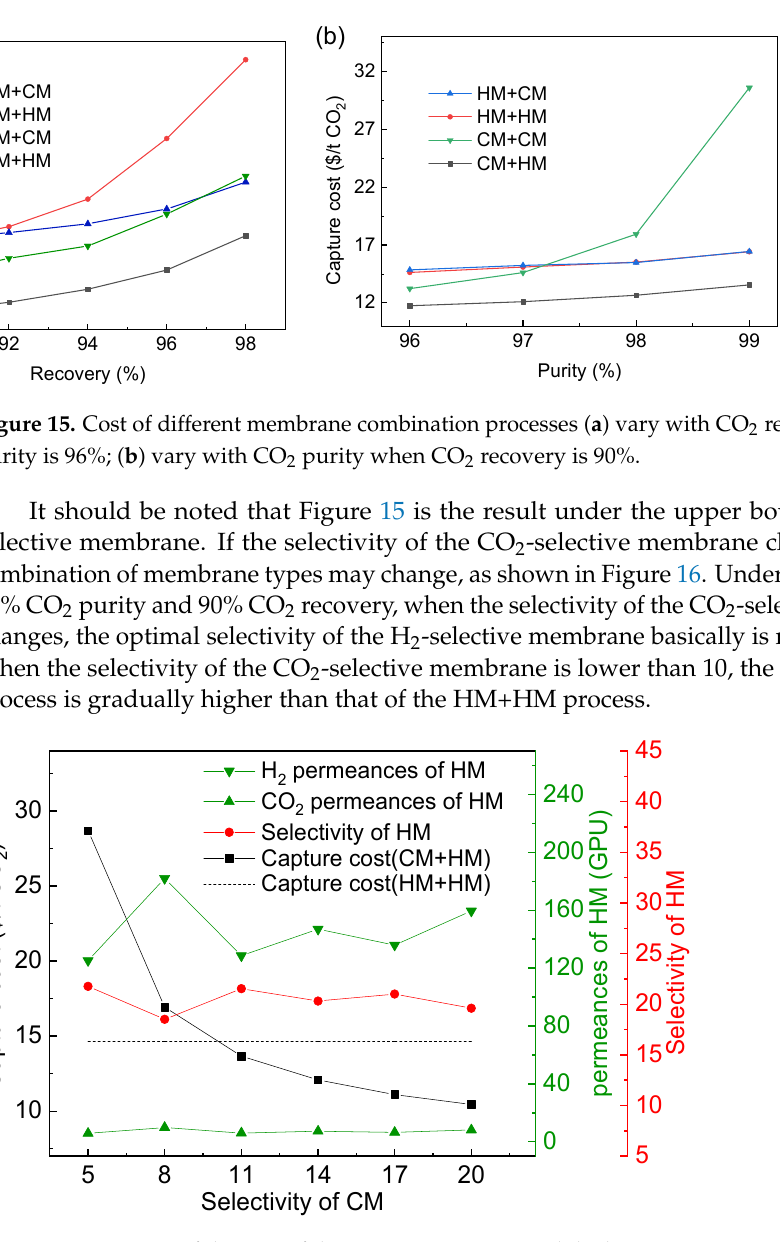
Figure 16. Variation of the cost of the CM+HM process and the best separation performance of HM with the change of the selectivity of CM.